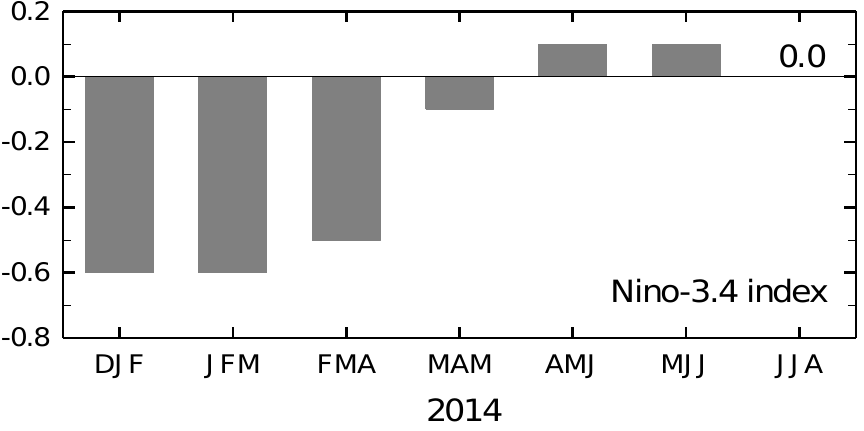
Figure 11. Time series of Niño-3.4 index in 2014.